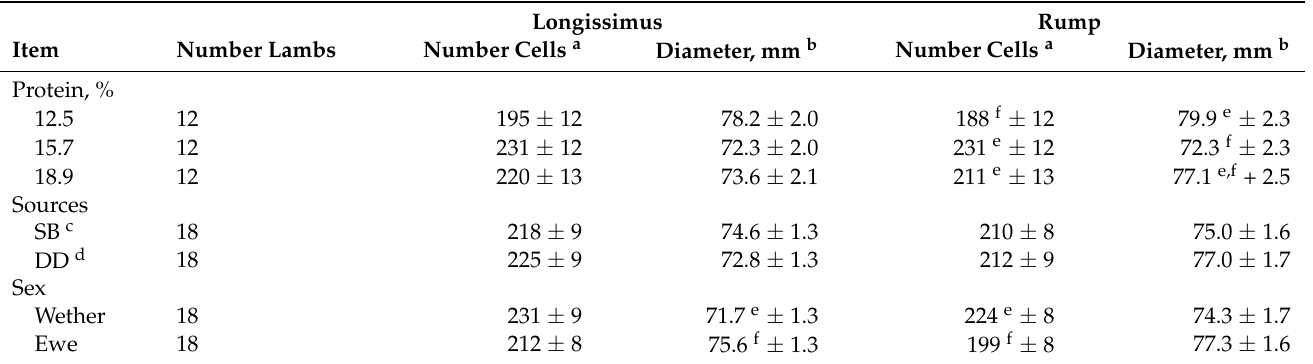
Table 4. Least squares means and standard errors for subcutaneous fat cell numbers and diameters of longissimus and rump mucle. Longissimus